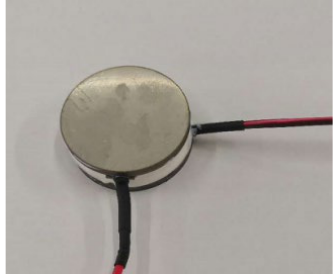
Figure 4. A prototype of piezoelectric sensing unit.